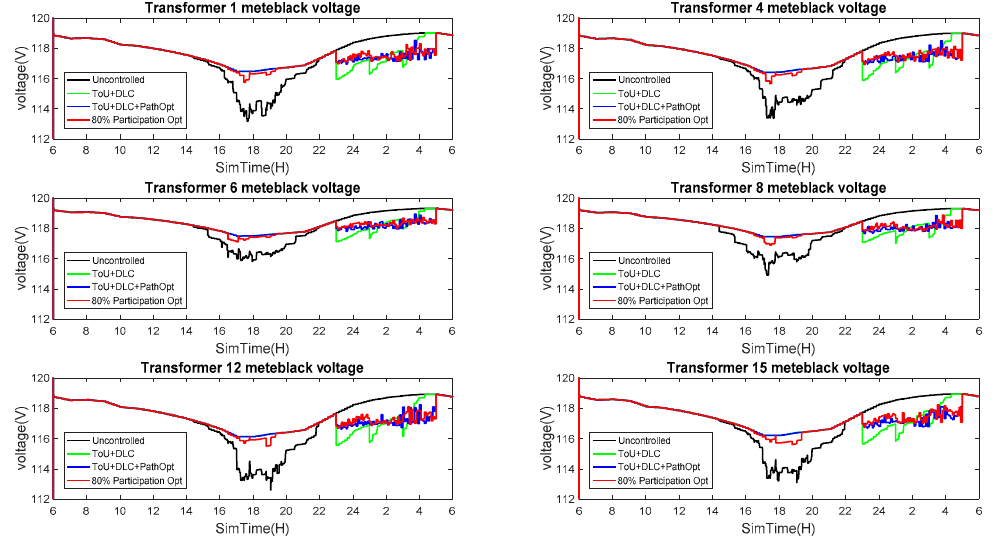
Figure 9. Service voltage deviation in uncontrolled charging, ToU + DLC charging, ToU + DLC + optimal control charging, and 80% participation rate of ToU + DLC + optimal control charging.